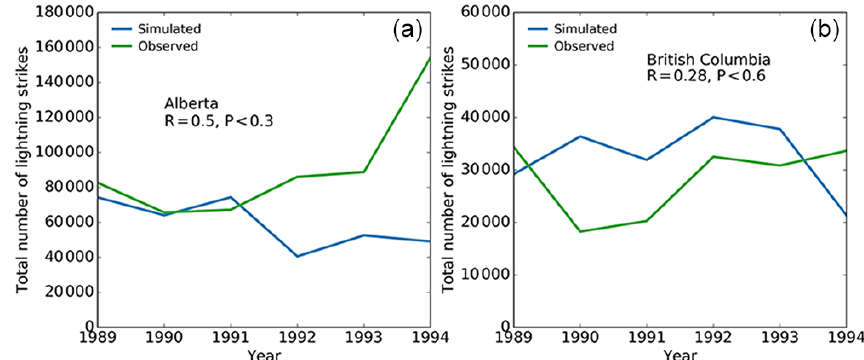
Figure 1. Observed and simulated number of lightning strikes in the central cordillera of Canada (a) in Alberta and (b) in British Columbia.